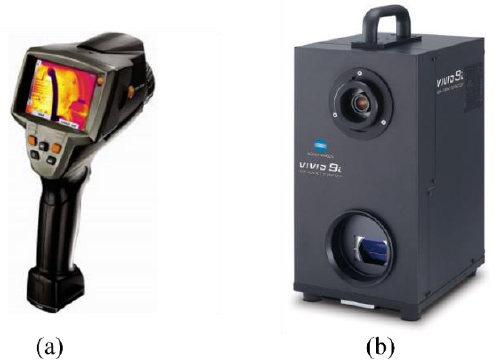
Figure 1. ( a ) Thermal camera Testo 882. ( b ) Laser scanner Konica Minolta Vivid 9i.